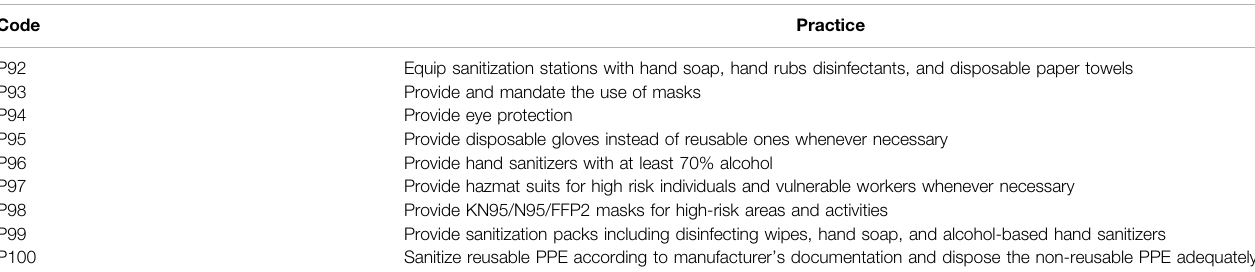
TABLE 13 | Recommended practices to provide safety wearables and